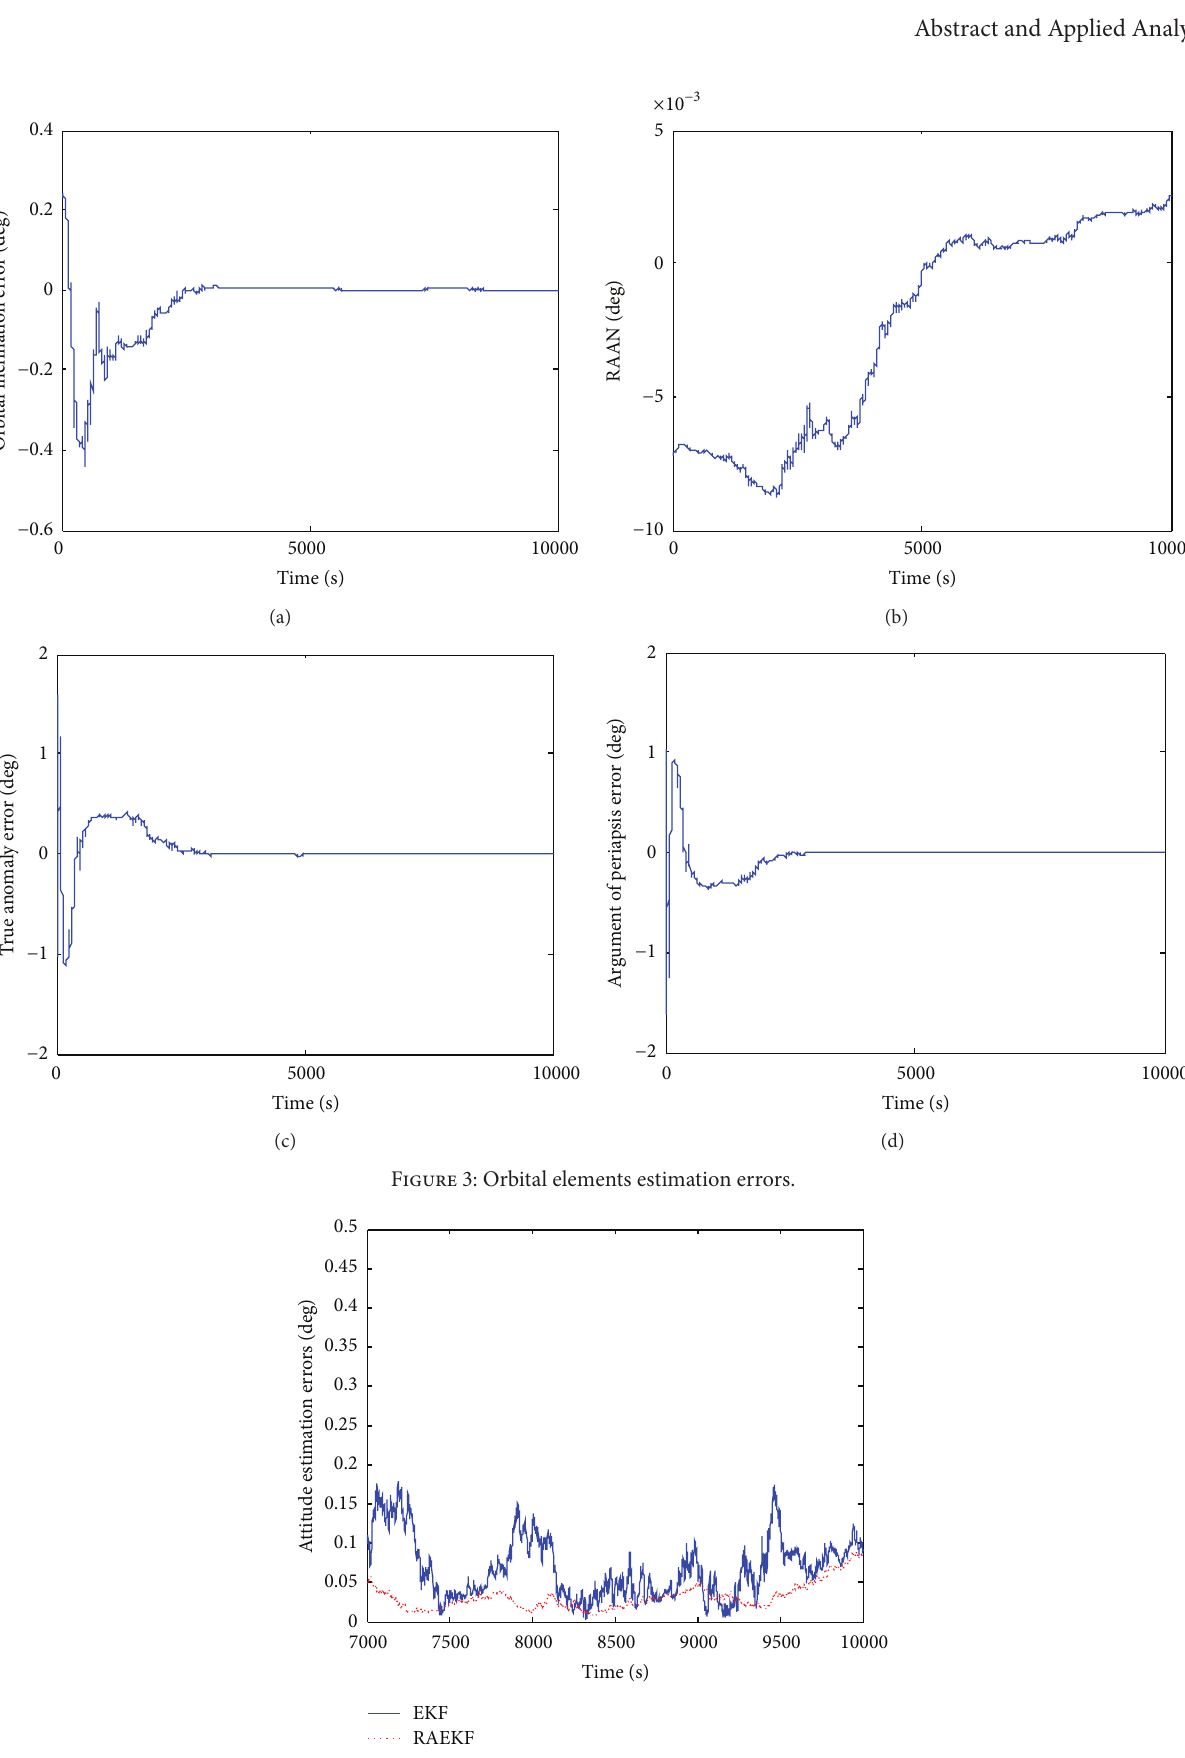
Figure 4: Attitude estimation errors